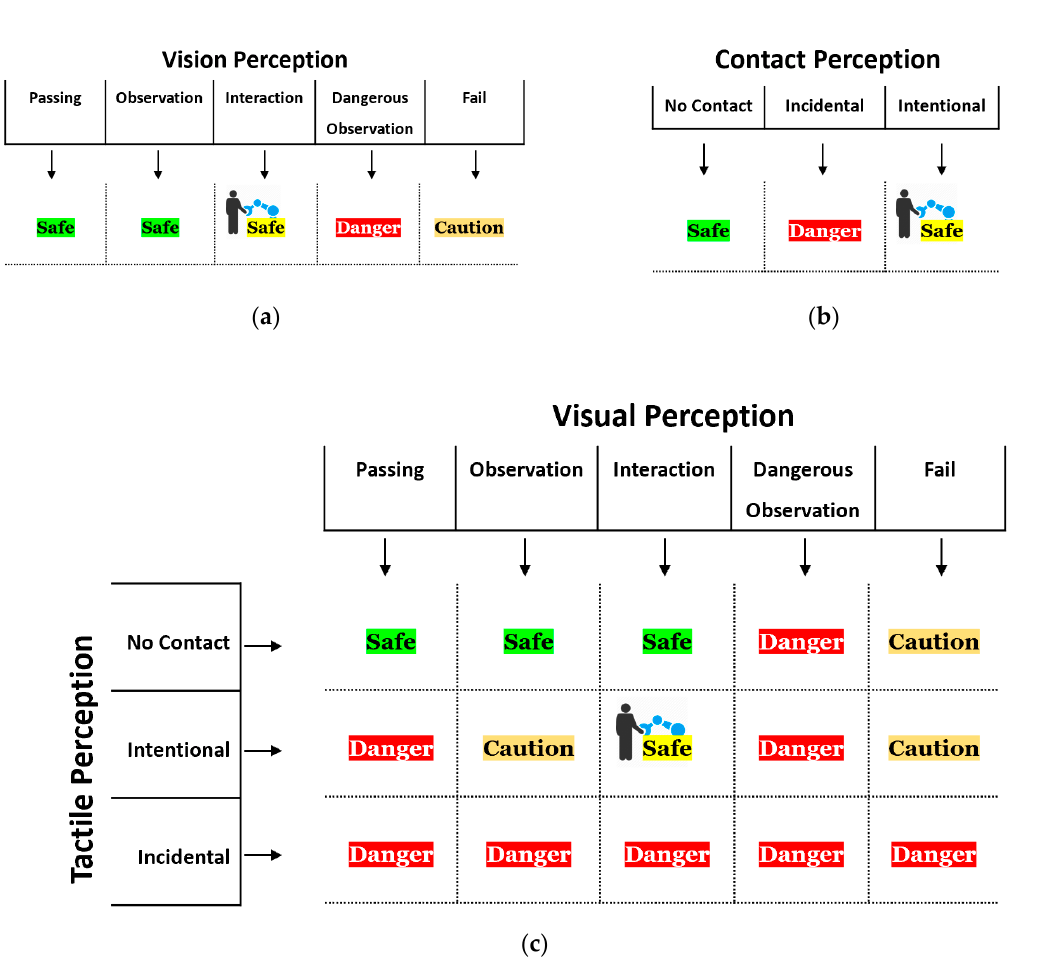
Figure5. Safetyperceptionspectrumin( a )visualperception, ( b )contactperception, ( c )mixedperception Figure 5. Safety perception spectrum in ( a ) visual perception, ( b ) contact perception, ( c ) mixed safety perception safety systems.